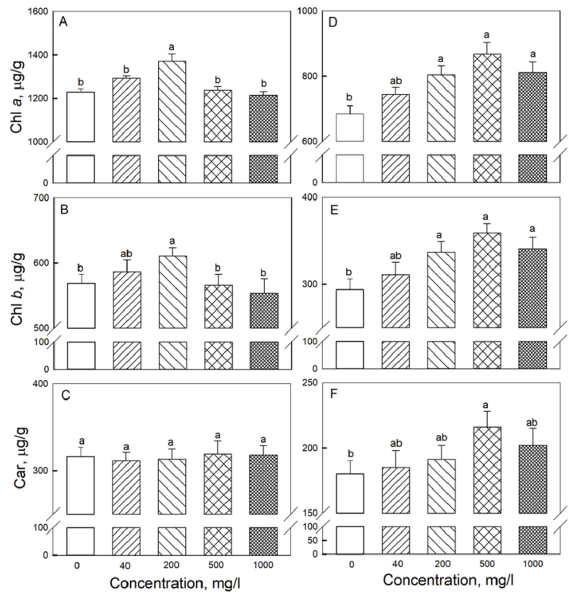
Figure 5. Effects of seed treatment with various concentrations of Fe 3 O 4 nanoparticles on pigment